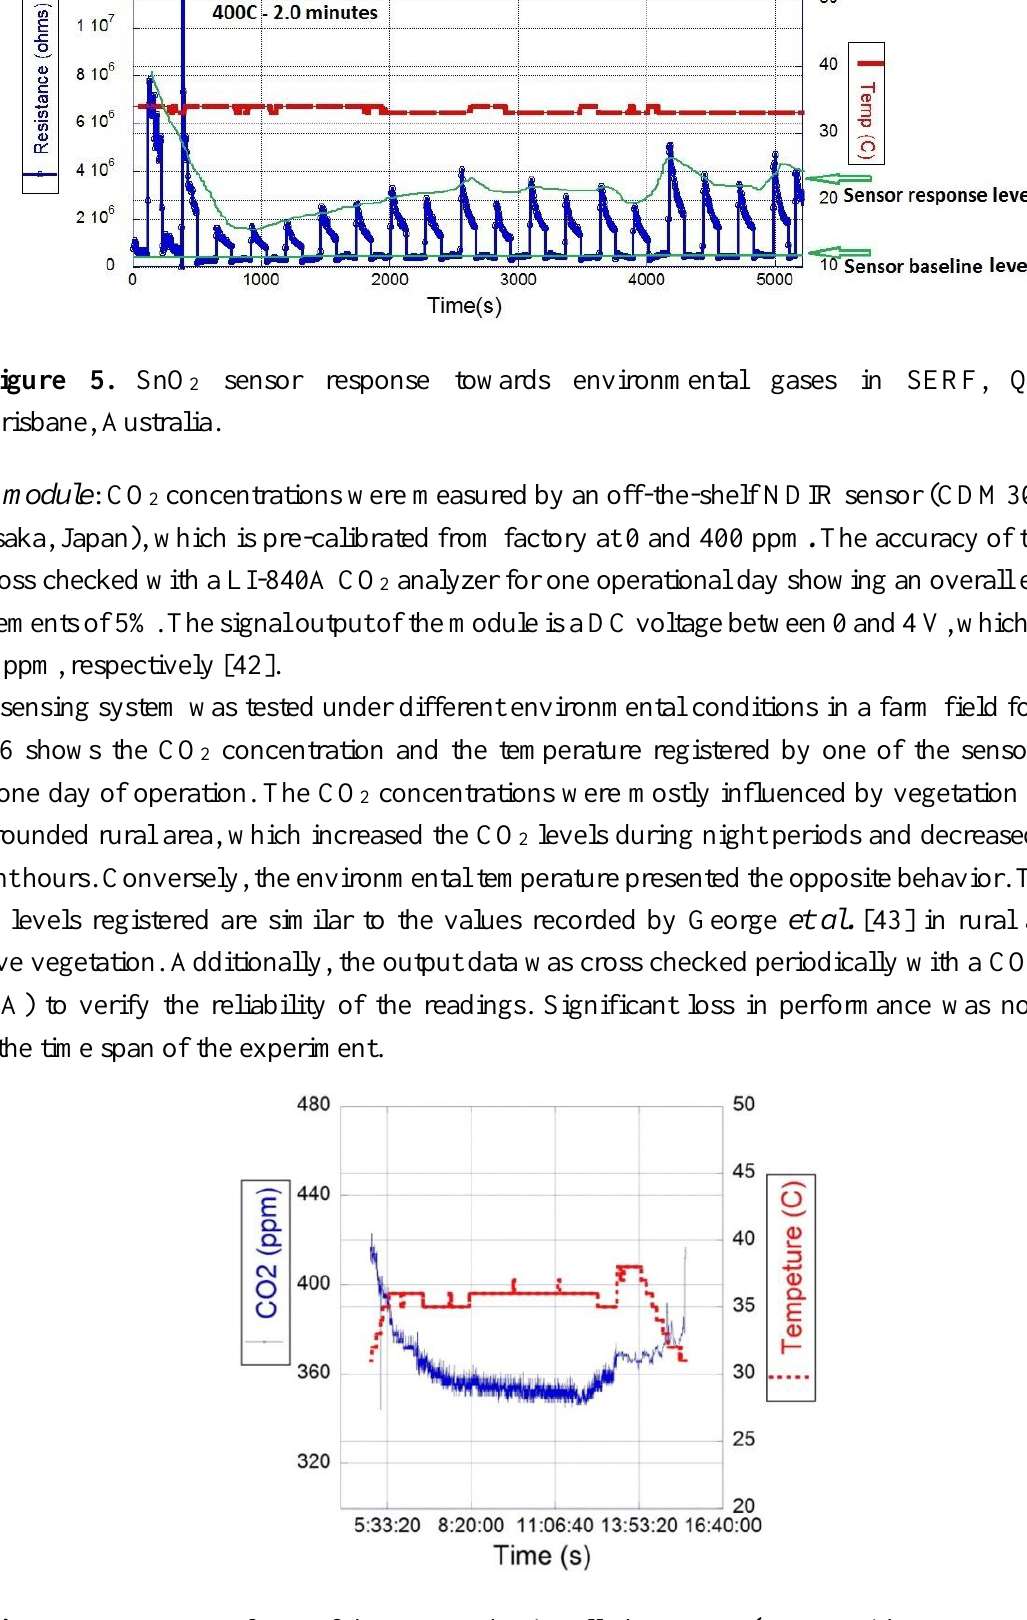
Figure 6. Response of one of the CO 2 nodes installed at SERF (QUT, Brisbane, Australia) during one day of